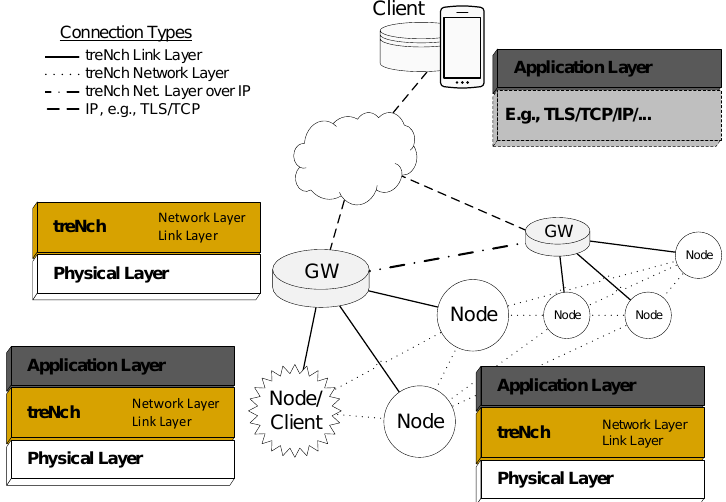
Figure 3. treNch network and protocol stack per